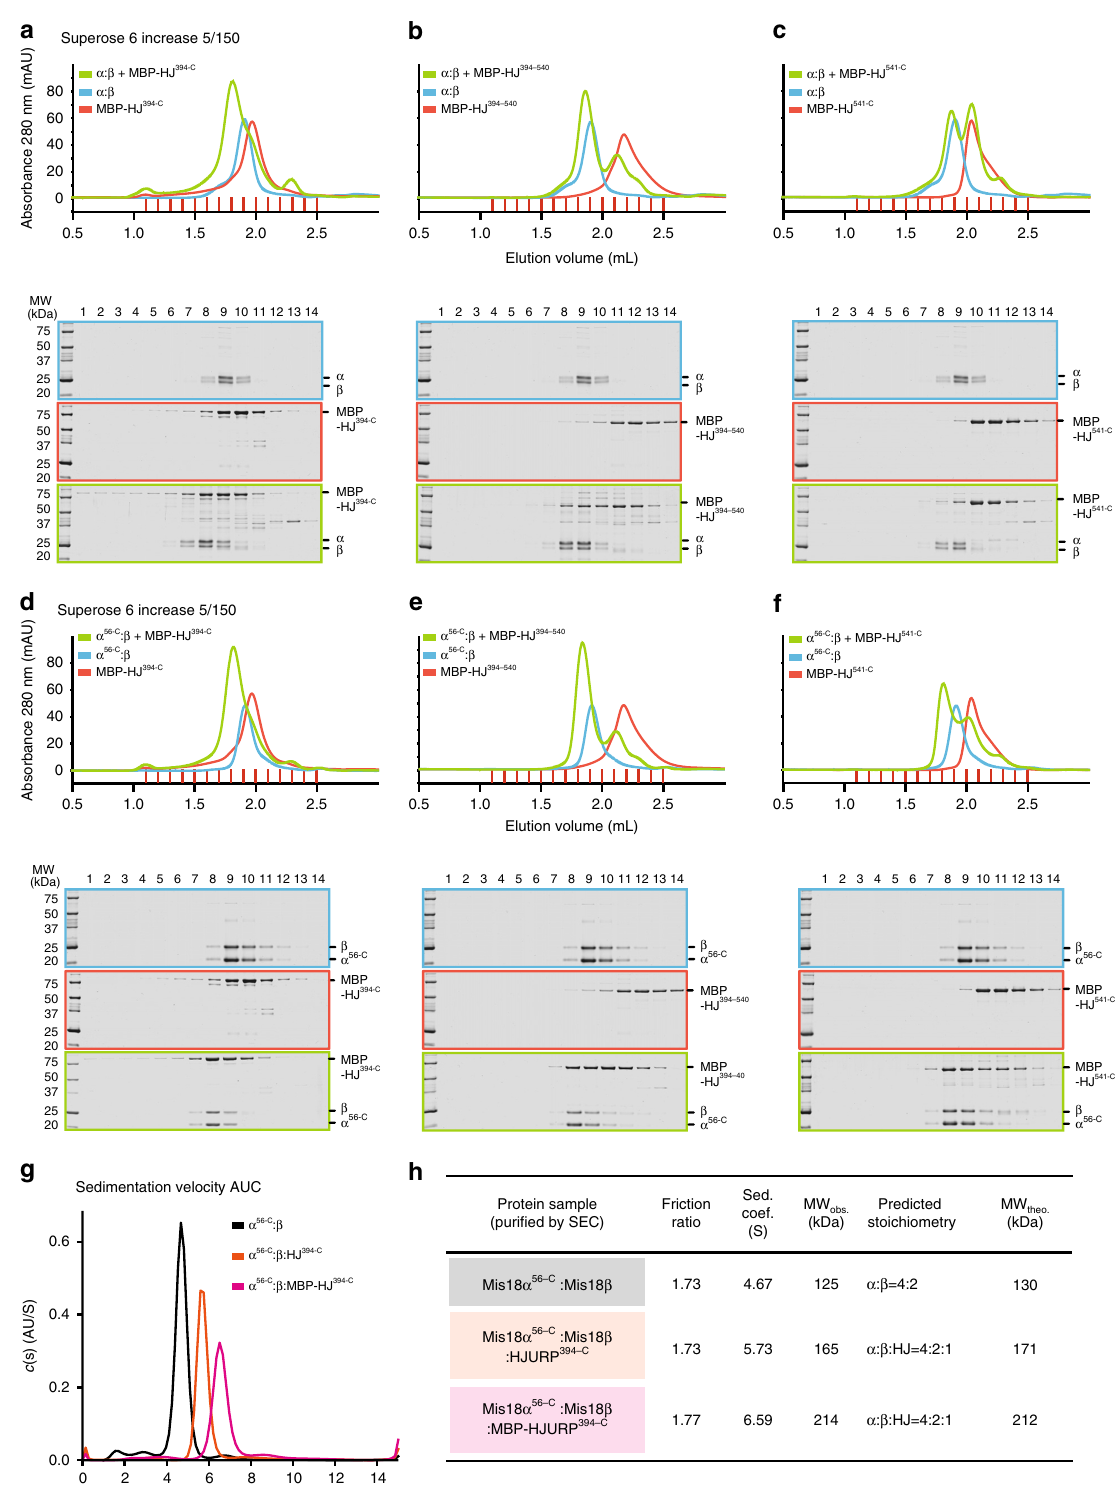
Fig. 5 Mis18 core forms stable complex with only one copy of HJURP. a – f Analytical SEC experiments were performed to con fi rm that HJURP fragments bind full-length Mis18 core or Mis18 α 56 – C :Mis18 β without dissociation of these complexes. SDS-PAGE gels were stained with CBB. g Sedimentation coef fi cient distributions obtained from the sedimentation velocity AUC experiments using the puri fi ed samples described in Supplementary Fig. 6a, b. Data pro fi les used for curve- fi tting analyses are shown in Supplementary Fig. 6c. h A table showing the values obtained from the AUC experiments in panel g . Sed. coef. sedimentation coef fi cient, MW obs. observed molecular weight, MW theo. theoretical molecular